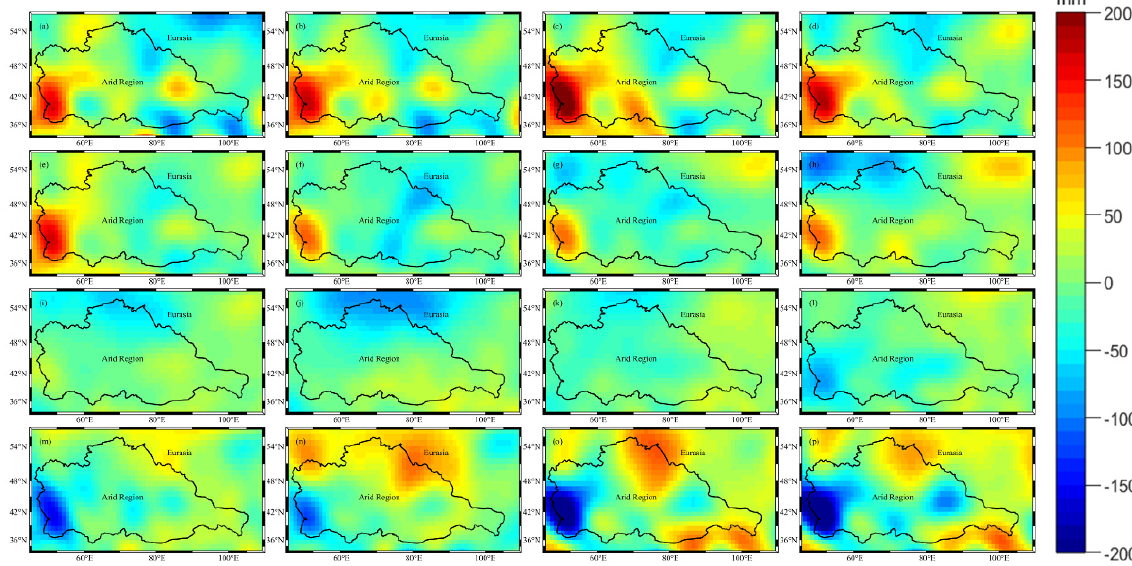
Figure 2. Annual variation of TWS in arid regions of Central Asia from 2003 to 2020.